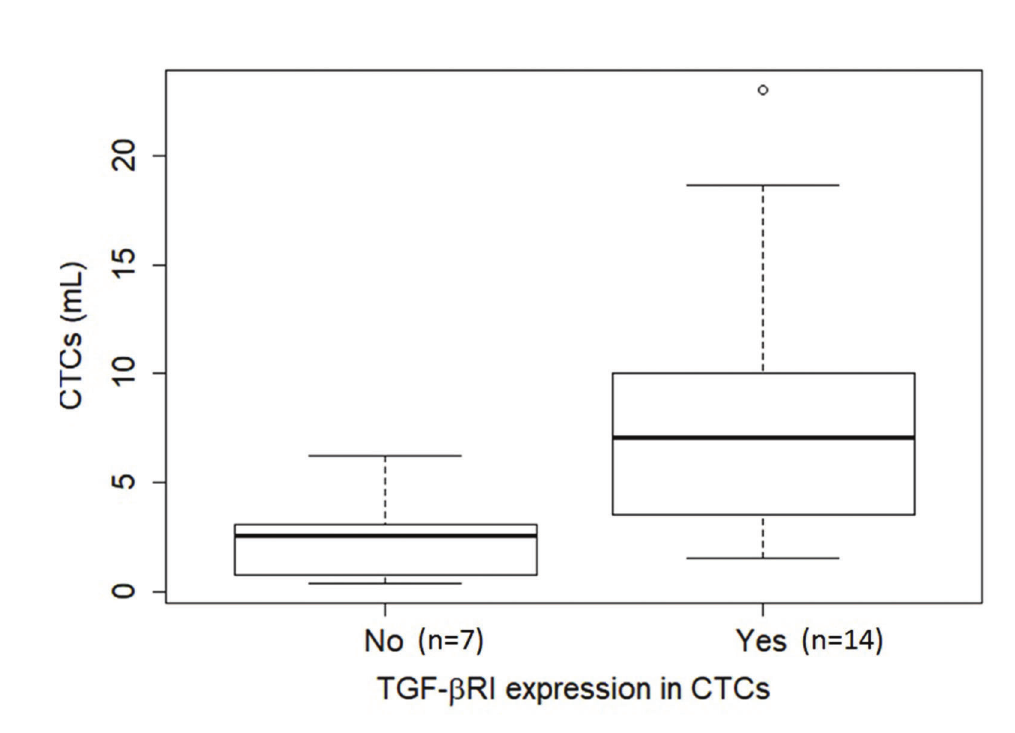
Figure 4 - Boxplot of the relationship of CTC abundance (per mL blood) with TGF- b RI expression in CTCs. The median number of CTCs was 7 CTCs/mL blood (range, 1.5–23/mL blood) in the presence of TGF- b RI expression (14 cases) and 2.5 CTCs/mL blood (range, 0.4–6.2/ mL blood) in its absence (7 cases), but without statistical significance ( p =0.09), as determined using the Mann–Whitney U test. Note that in six cases, no CTCs were found in the ISET s spots, hence it was not possible to evaluate TGF- b RI expression. Abbreviations: CTCs, circulating tumor cells; TGF- b RI, transforming growth factor-beta receptor